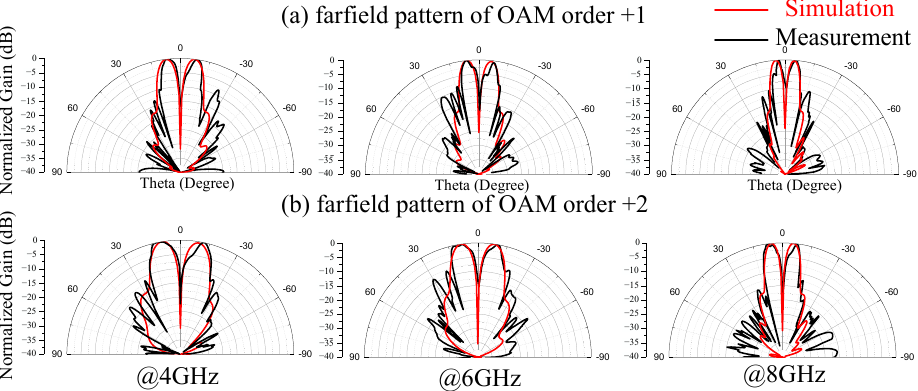
Figure 9. Measured and simulated far-field pattern of the reflected RHCP vortex beam: ( a ) OAM order + 1. ( b ) OAM order + 2.